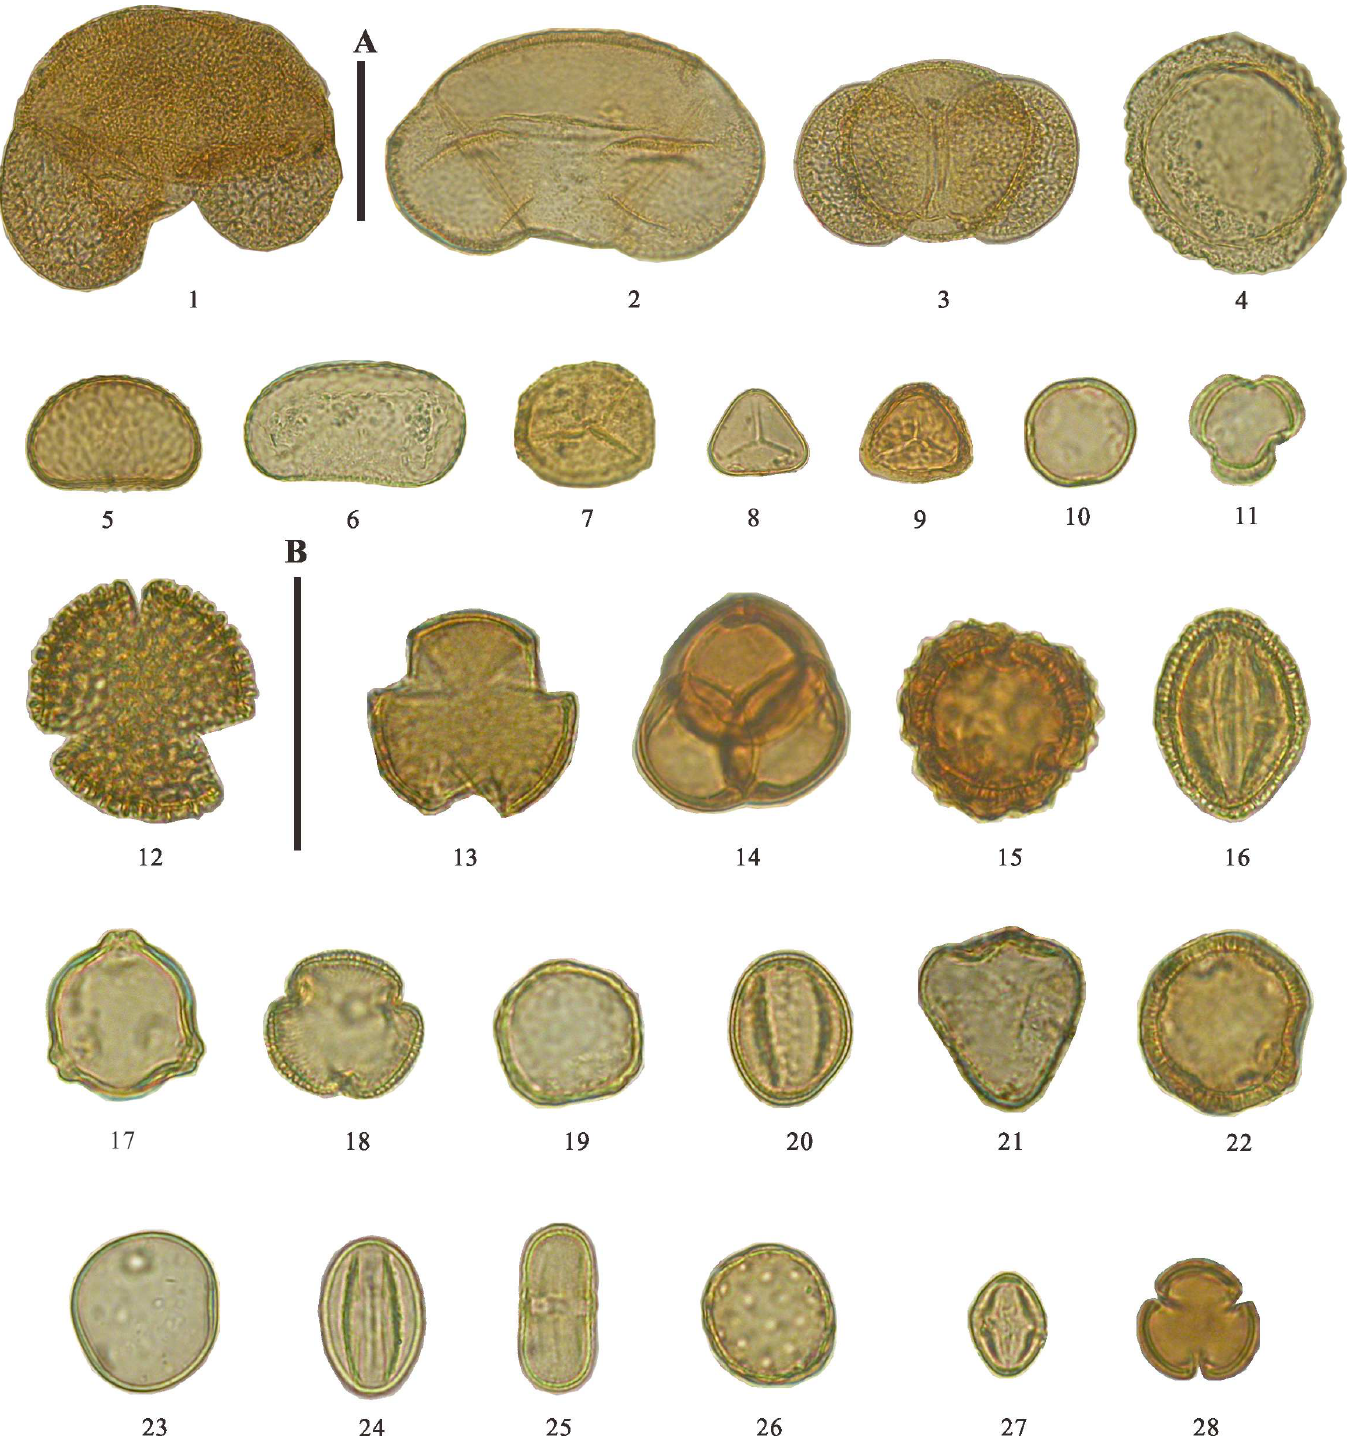
Fig 4. Examplesof palynomorphs recovered from ShuduLake core sediments1. Abies L. 2. Picea Dietr. 3. Pinus L. 4. Tsuga Carr. 5. Polypodiaceae 6. Athyriaceae 7. Hymenophyllaceae8. Gymnogrammaceae 9. Pteris L. 10. Plantaginaceae 11. Artemisia L. 12. Oleaceae13. Rosaceae14. Ericaceae 15. Asteraceae 16. Polygonaceae 17. Betula L. 18. Verbenaceae19. Ulmus L. 20. Quercus L. 21. Cyperaceae22. Amaranthaceae 23. Poaceae24. Salix L. 25. Apiaceae26. Chenopodiaceae 27. Castanopsis (D. Don) Spach. 28. FabaceaeScale bar = 50 μ m (scale bar A appliesto 1–9, scale bar B appliesto 10–28).